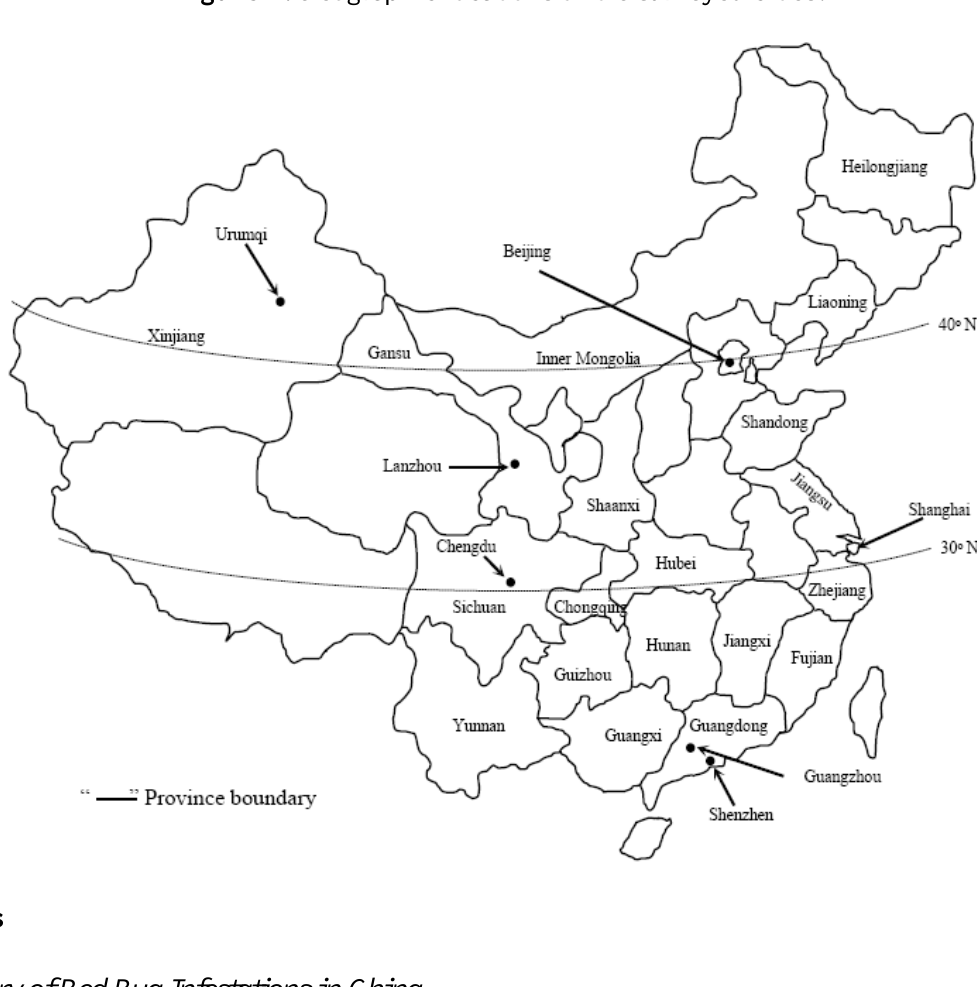
Figure 1. Geographic locations of the surveyed